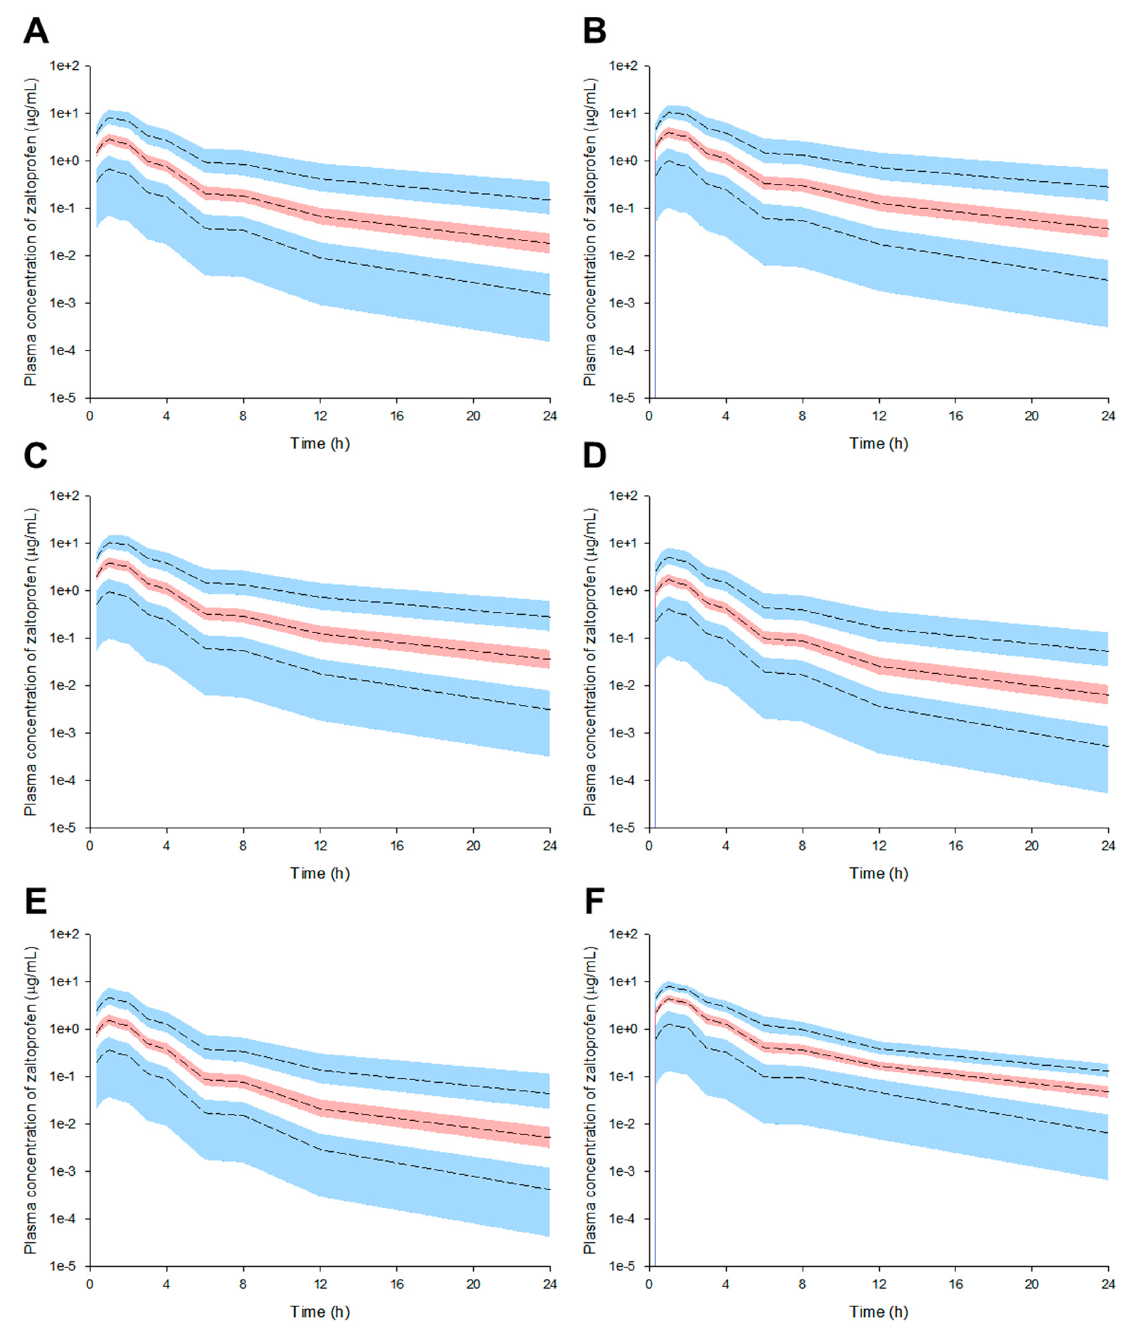
Figure 2. Pharmacokinetic prediction profiles after single oral administration of zaltoprofen (80 mg) according to the change in CrCL and albumin levels (( A ) CrCL 130 mL/min, ( B ) CrCL 80 mL/min, ( C ) Albumin 5.5 g/dL, ( D ) Albumin 3.5 g/dL, ( E ) CrCL 130 mL/min and albumin 3.5 g/dL, and ( F ) CrCL 80 mL/min and albumin 5.5 g/dL). CrCL 130 and 80 mL/min and albumin 5.5 and 3.5 g/dL were randomly assigned to the upper and lower limits of the general range of healthy adults, respectively. The 95th, 50th, and 5th percentiles of the predicted concentrations are represented by black dashed lines. The 95% confidence intervals (CI) for the predicted 5th and 95th percentiles are represented by the blue-shaded regions. The 95% CI for the predicted 50th percentile is represented by the red-shaded regions. The X-axis indicates the time after oral zaltoprofen administration and the Y-axis is the predicted concentrations of zaltoprofen in the